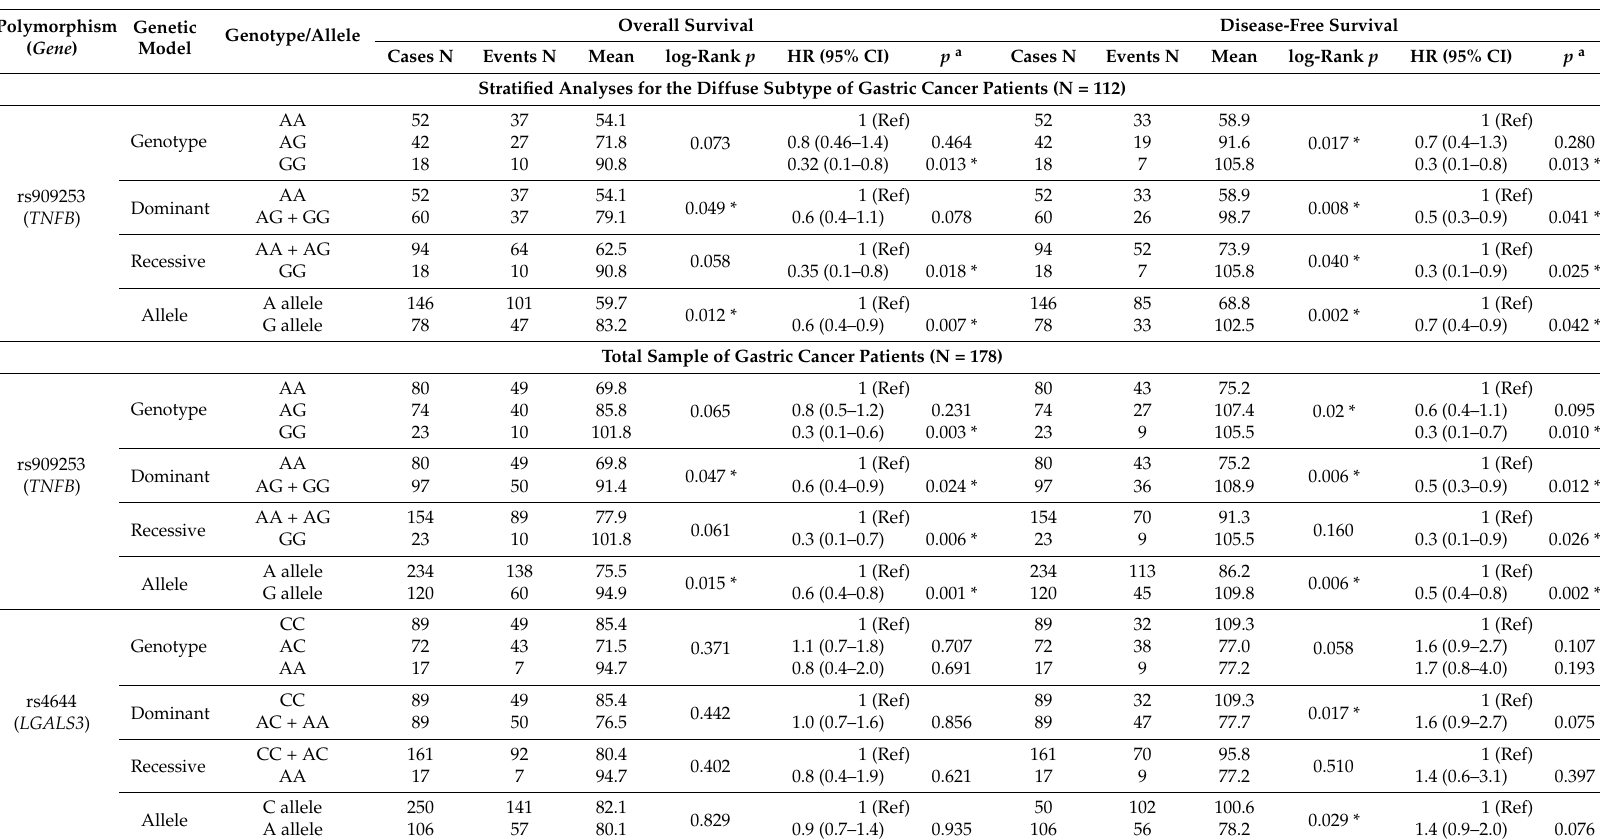
Table 4. Gastric cancer overall and disease-free survival according to the significant associated polymorphisms (rs909253 TNFB and rs4644 LGALS3 ), in the cases stratified for the diffuse histological subtype and in the total